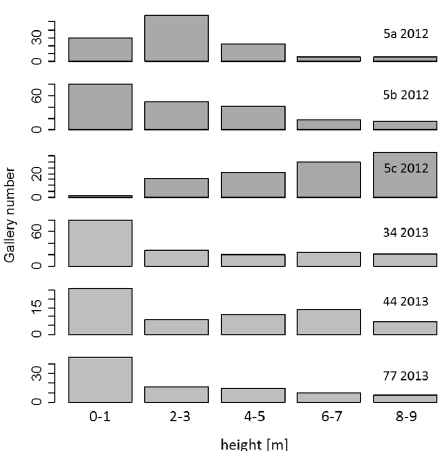
Figure 6. In relation to the height, the gallery numbers of six trees recently belonging to the vitality class 5 were determined in Gaden in two subsequent years. In 2012, the trees 5a–5c, and in 2013, the tress 34, 44 and 70 were measured.